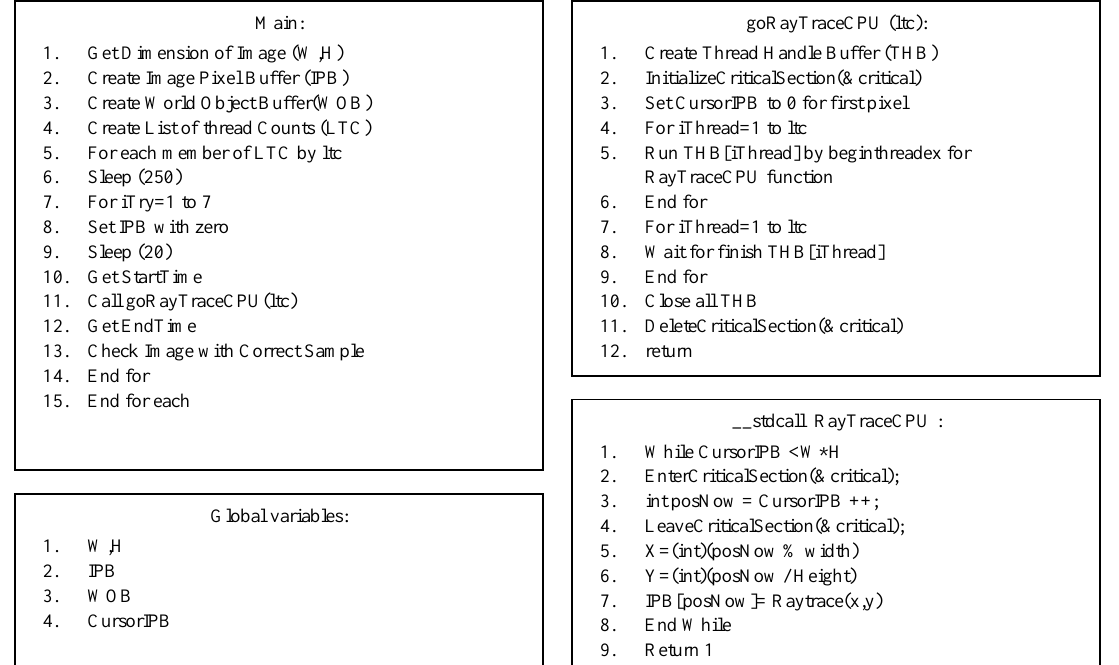
Figure 6. Pseudocode of raytrace alghorithm by